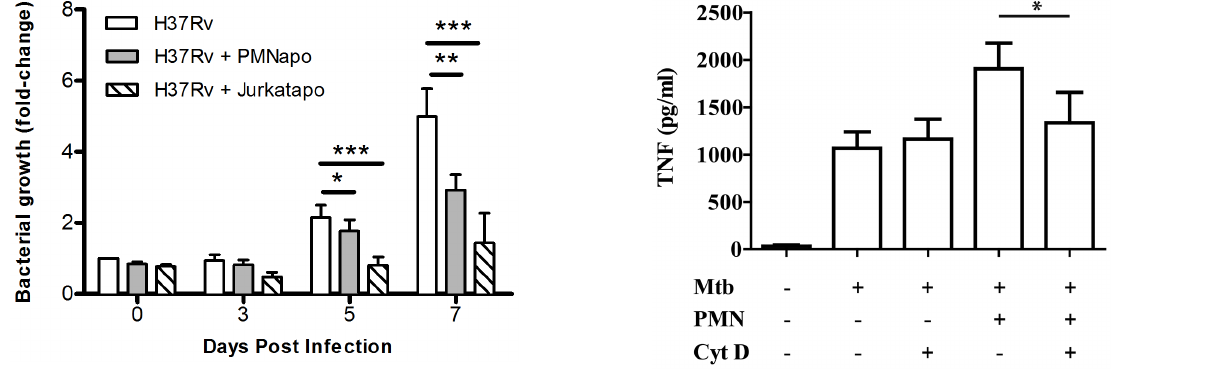
Figure 4. The augmentation of hMDM activation is dependent specifically on phagocytosis of apoptotic neutrophils. hMDMs were pre-incubated with or without cytochalasin D (CytD) prior to stimulation with c -irr Mtb at a ratio of 5:1 alone (Mtb) or together with PMNapo at a ratio of 2:1 (Mtb + PMNapo) for one hour where after non- ingested prey were removed and the hMDMs were cultured for 18 h. Data are expressed as mean TNF a released + SEM (n=3).